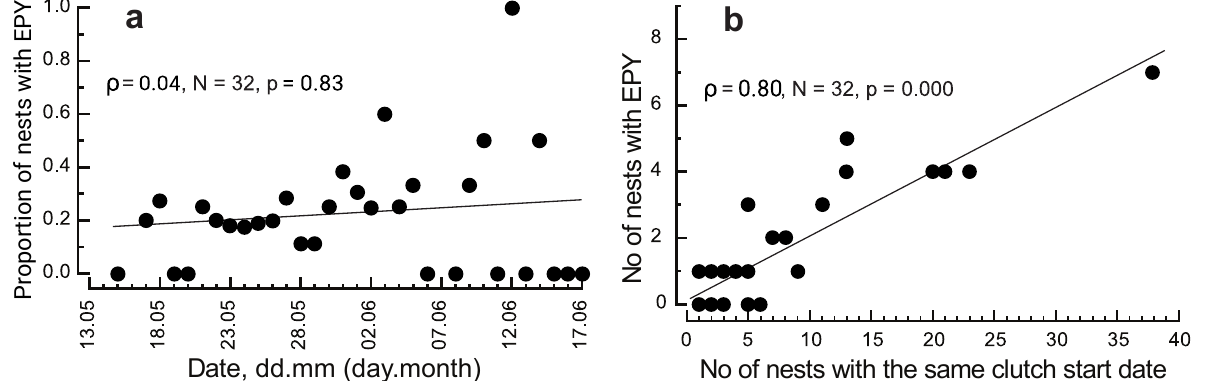
Figure 3. The link between the proportion of nests with EPY and the clutch start date ( a ) and between the number of nests with EPY and the total number of nests that a clutch has started on the respective date ( b ). The value of Spearman’s correlation ( ρ ), sample size (N) and significance level ( p ) are given. Linear regression (solid line) is